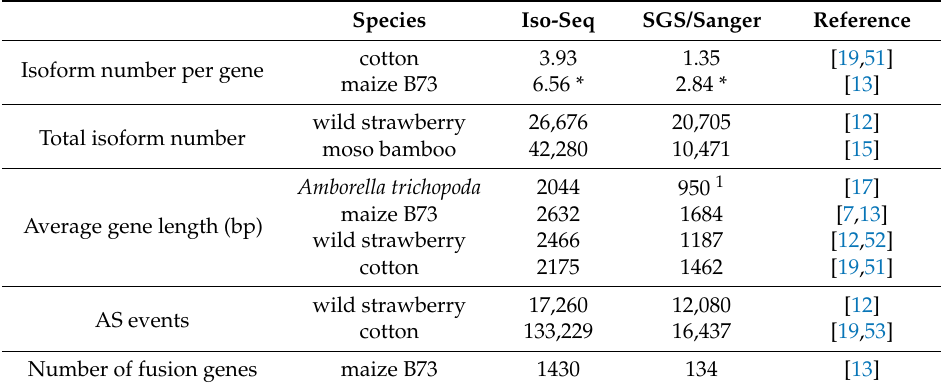
Table 5. Comparison of detecting efficiency in terms of isoform number, average gene length, AS events, and fusion genes between Iso-Seq and